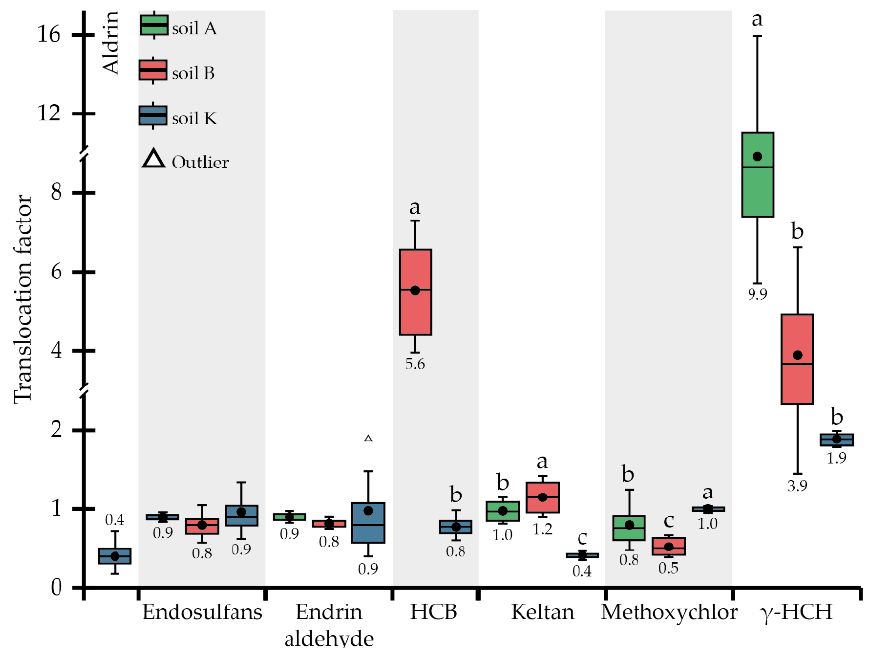
Figure 2. Translocation factors of OCPs. Different letters on the boxplots within one compound indicate a significant difference at p < 0.05. Endrin aldehyde was accumulated in the plant’s organs for all research soils; the concentration of this substance in the plant tissues was higher for soil A (354 µ g kg − 1 ) compared to soil B (256 µ g kg − 1 ) and soil K (179 µ g kg − 1 ), and all pairs were significantly different. Similar to endosulfans, concentrations of endrin aldehyde in plant tissues were inversely correlated with concentrations in soils: BCF for AGB decreased from 5.4 (soil A) to 0.2 (soil K), and BCF for roots from 6.0 (soil A) to 0.2 (soil K), while OCP